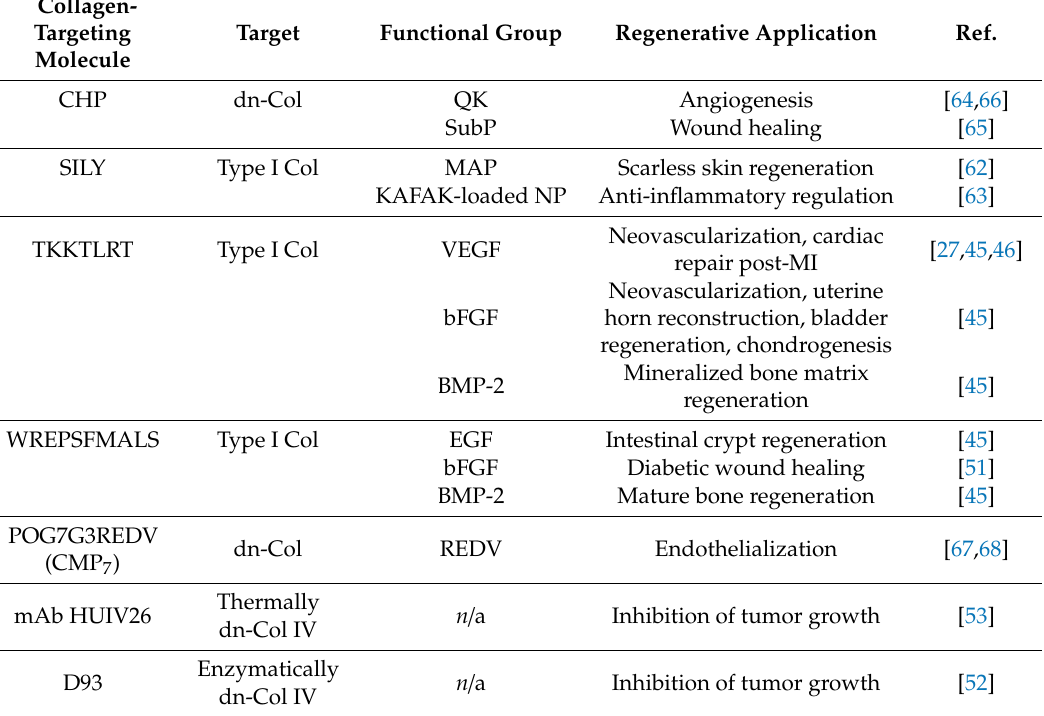
Table 1. Functionalized collagen-targeting molecules for regenerative